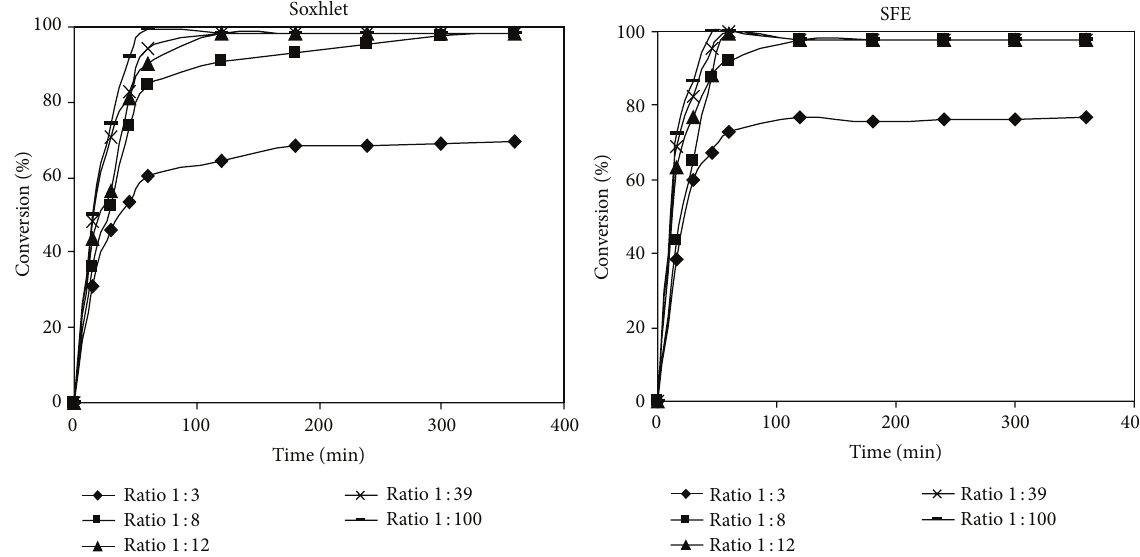
Figure 5: Acid-catalysed transesterification of oils obtained by Soxhlet extraction and by SFE with carbon dioxide at 400 bar and 35 ∘ C.